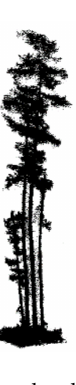
Figure 4. The most closely grouped